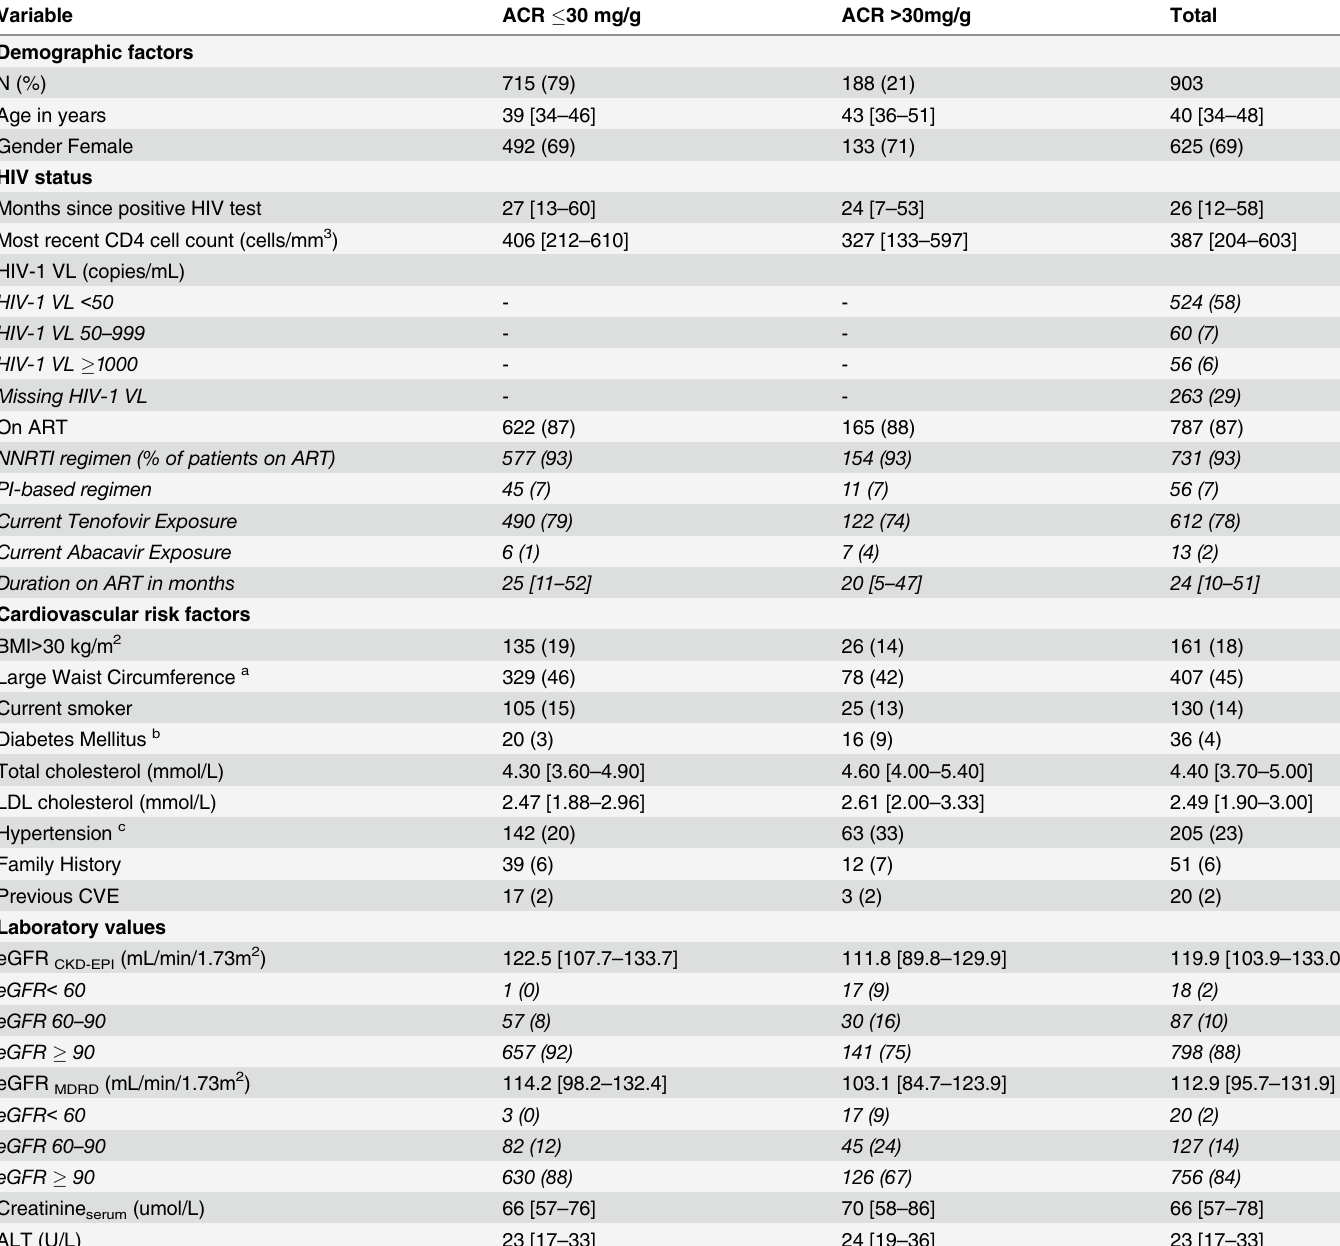
Table 1. Characteristics of the study